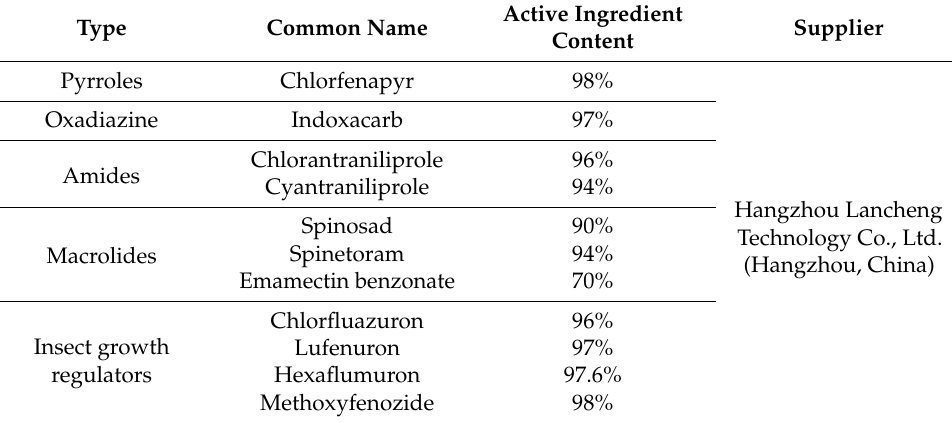
Table 1. Insecticides used for